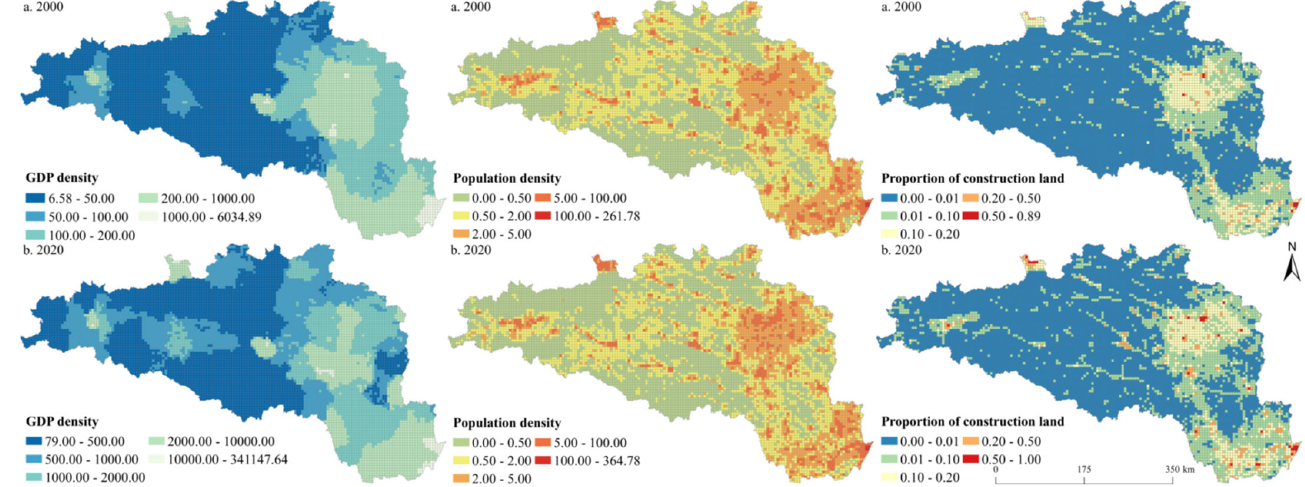
Figure 4. Spatial pattern of urbanization elements at the 5 km grid scale in the HREEB in China.